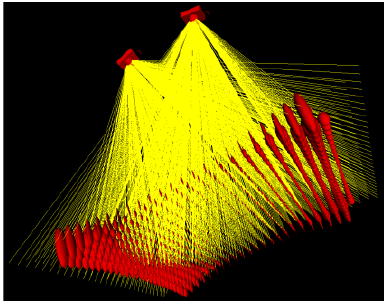
Figure 12: Stereo error propagation in object space by Monte-Carlo